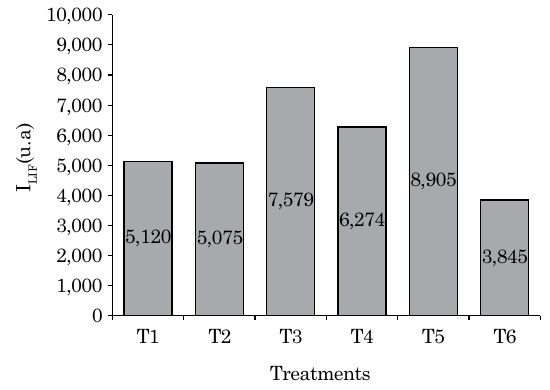
Figure 3. Laser-induced fluorescence index (I liF ) of organic matter in the 0.00-0.03 m layer of a constructed soil under cover crops, a bare